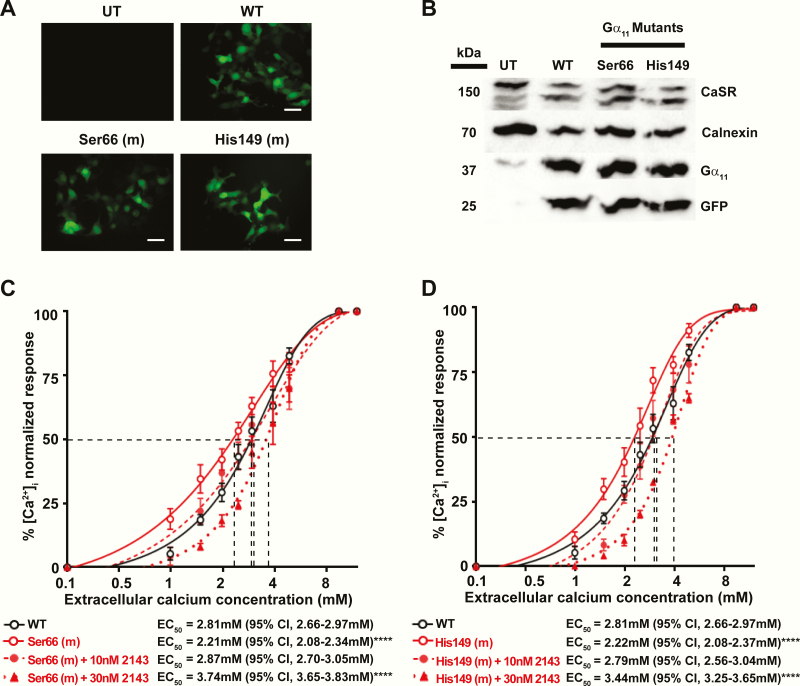
Functional characterization of wild-type (WT) and ADH2-associated mutant Gα 11 proteins with Gly66Ser and Arg149His substitutions, using intracellular calcium (Ca2+i) responses, and assessing the effects of the calcilytic NPS 2143 (2143). (A) Fluorescence microscopy of HEK293 cells stably expressing CaSR (HEK-CaSR) and transiently transfected with WT (Gly66 and Arg149) or ADH2-associated mutant (m) Ser66 or His149 pBI-CMV2-GNA11 constructs. UT, untransfected cells. GFP indicates successful transfection and expression of Gα 11 by these constructs. Bar indicates 10 μm. (B) Western blot analysis of CaSR, Gα 11, and GFP using lysates from HEK-CaSR cells transiently transfected with WT or mutant Ser66 or His149 expression constructs. Calnexin was used as a loading control. (C-D) Ca2+i response to changes in [Ca2+]e of HEK-CaSR cells transfected with: (C) WT or Ser66 Gα 11 mutant or (D) WT or His149 Gα 11 mutant, measured by Fluo-4 calcium assays. (C-D) The Ca2+i responses to changes in [Ca2+]e are expressed as a percentage of the maximum normalized responses and shown as the mean ± SEM of 4–8 independent transfections. The Ser66 and His149 Gα 11 mutants led to a leftward shift in the concentration-response curve (solid red line). The addition of 10 nM (red dashed line) or 30 nM (red dotted line) 2143 rectified the leftward shift of the Ser66 and His149 Gα 11 mutants, when compared with WT (black line). The mean half-maximal concentration (EC50) of the responses with 95% confidence intervals (CI) and P values are shown below for each mutant compared with the WT response. Statistical analysis was performed using the F-test. ****P < 0.0001.